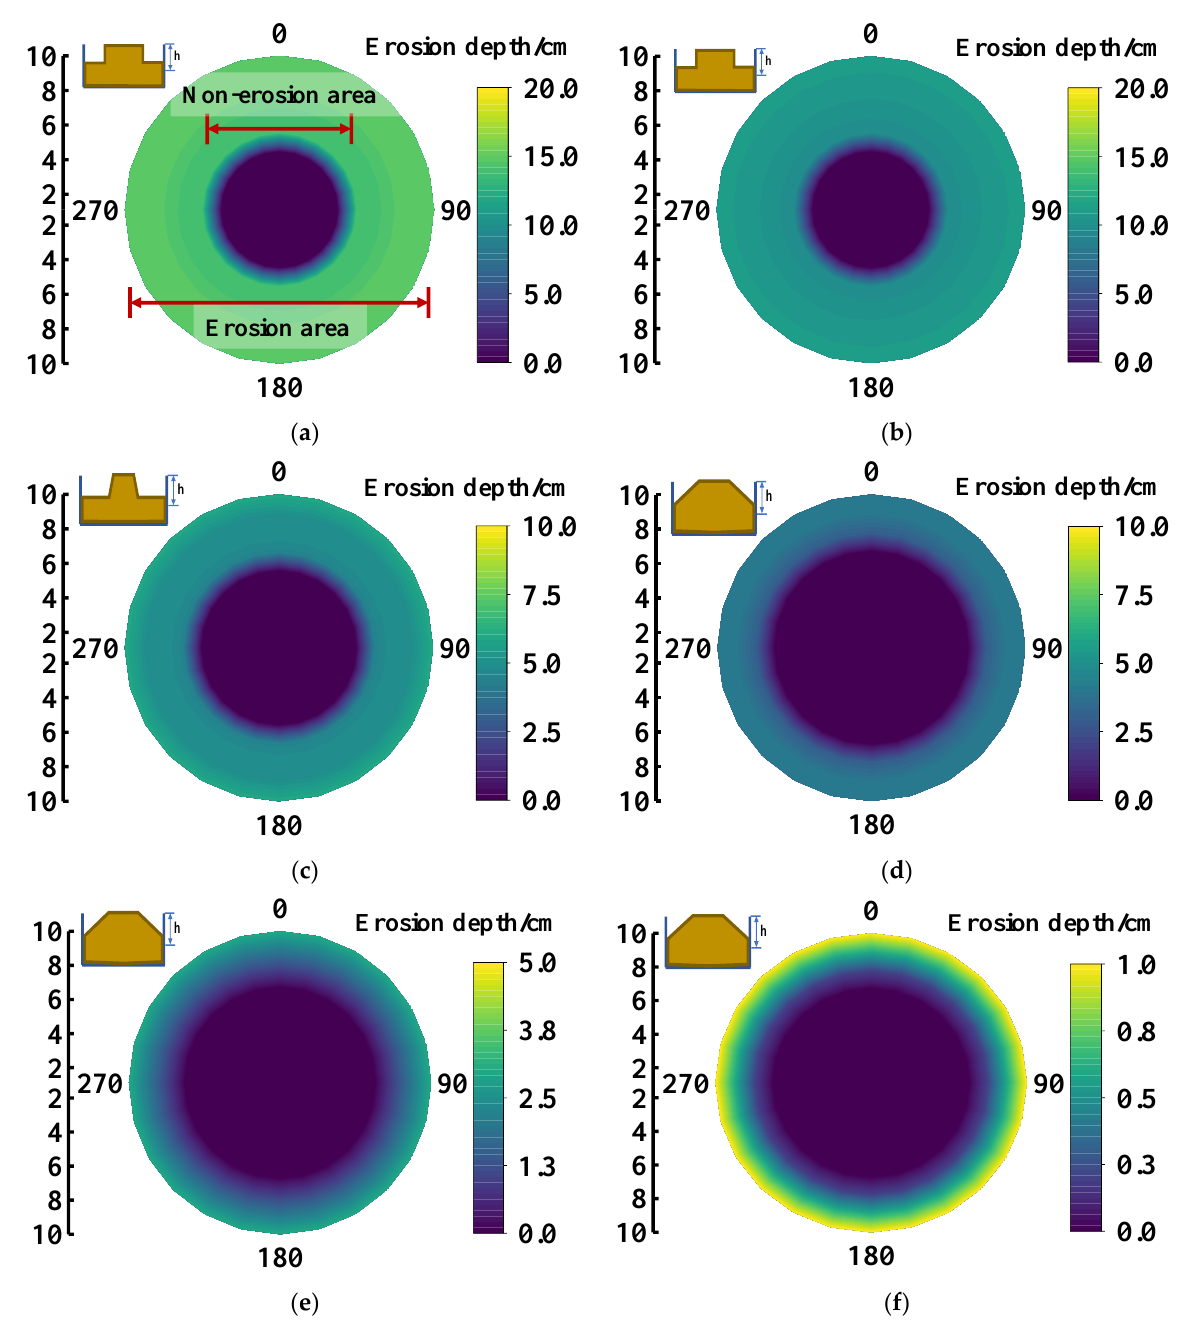
Figure 13. Erosion topography map for each test condition (initial setting). ( a ) 50 kPa ( w = 60 rad/s) ( b ) 100 kPa ( w = 50 rad/s) ( c ) 150 kPa ( w = 90 rad/s) ( d ) 200 kPa ( w = 100 rad/s) ( e ) 300 kPa ( w = 131 rad/s) ( f ) 400 kPa ( w = 153 rad/s).